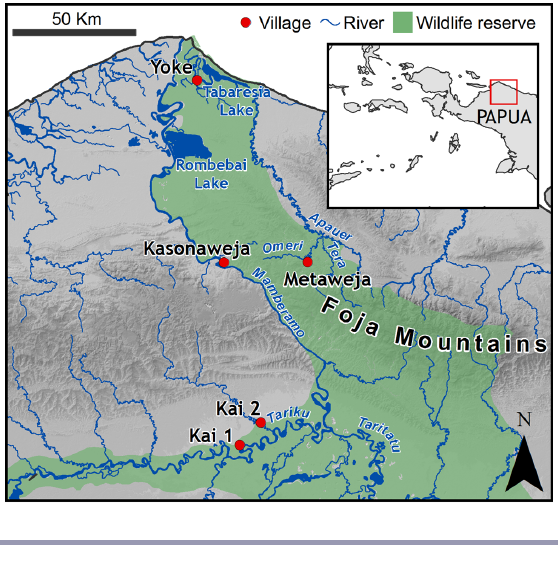
Fig. 1 . Map indicating the location of our study, Kay (1